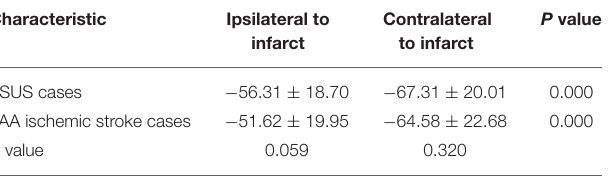
TABLE 2 | Perivascular fat density on CT angiography (measured in